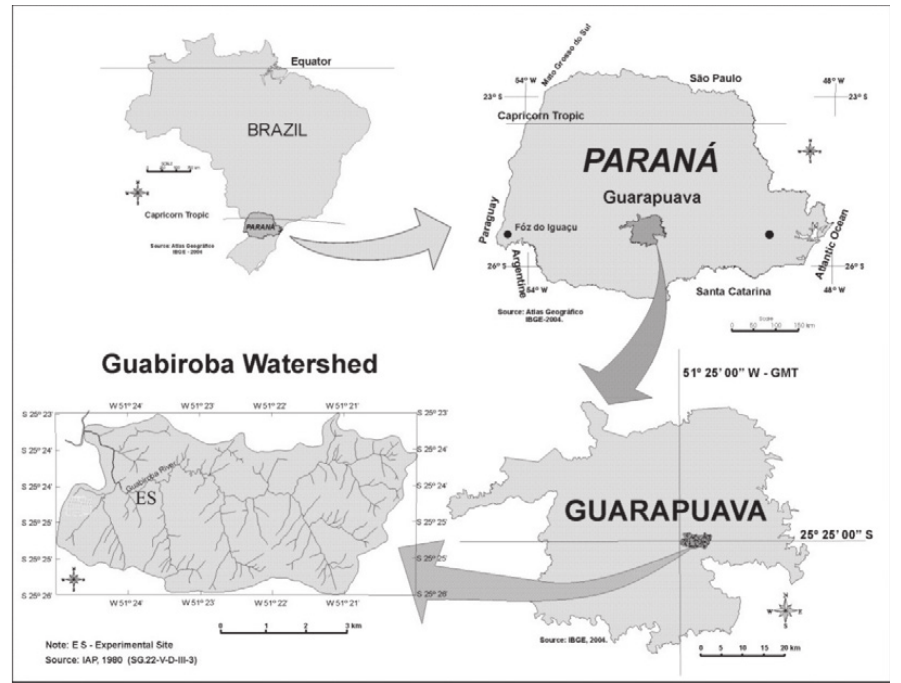
figure 1. Study area (eS: experimental